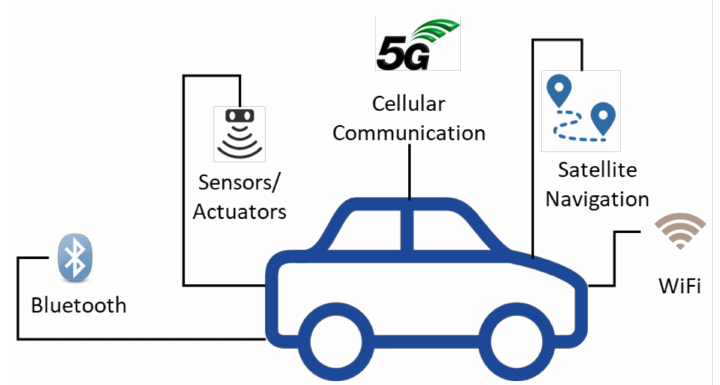
Figure 1. A typical smart vehicle